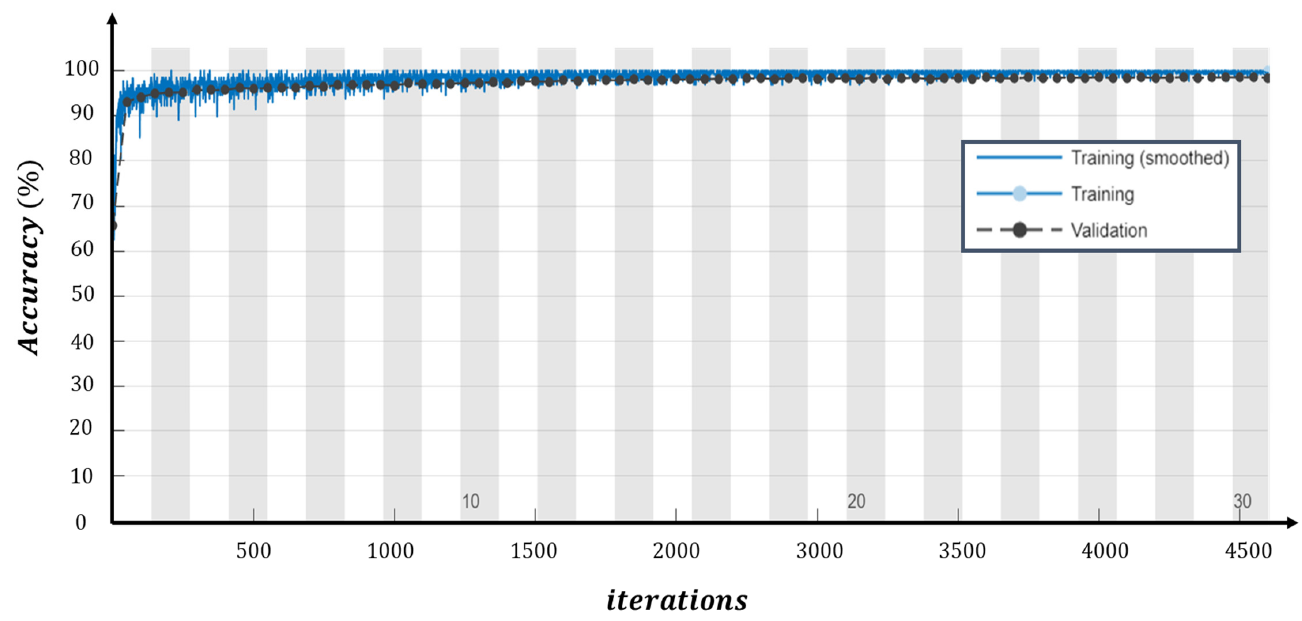
Figure 14. Training progress with respect to accuracy function.